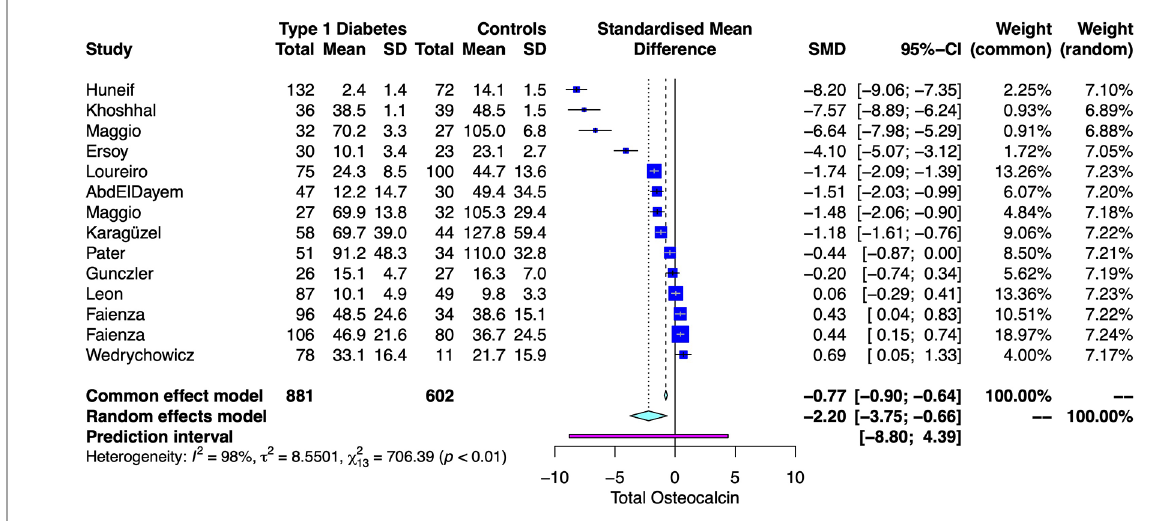
FIGURE 2 Forest plot with the individual results and the pooled estimates of tOC serum levels among T1D and controls.